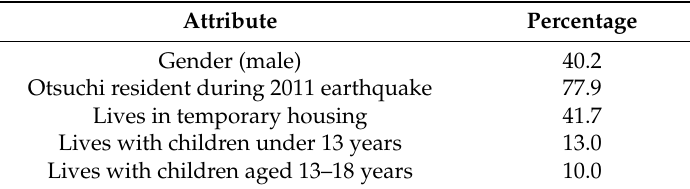
Table 2. Distributions of personal demographic attributes (%).